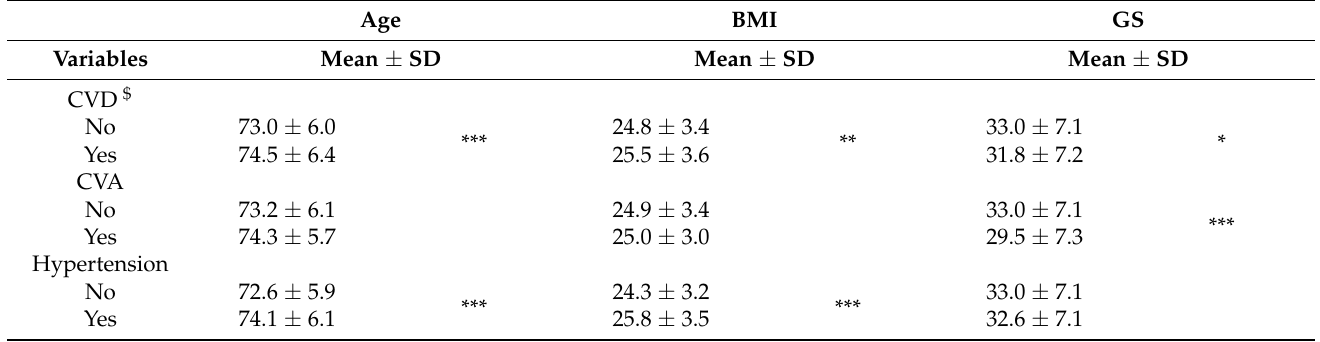
Table 2. Age, BMI, and grip strength distributions (mean ± SD) in different chronic disease statuses among male participants (n =